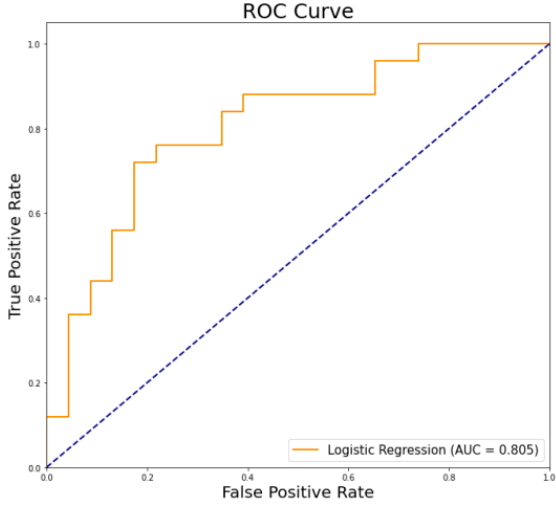
Figure 4. ROC curve was obtained by the logistic regression classifier. Table 2. Accuracy, empirical chance level, specificity, sensitivity, precision, F1 value, and AUC using logistic regression classifier.